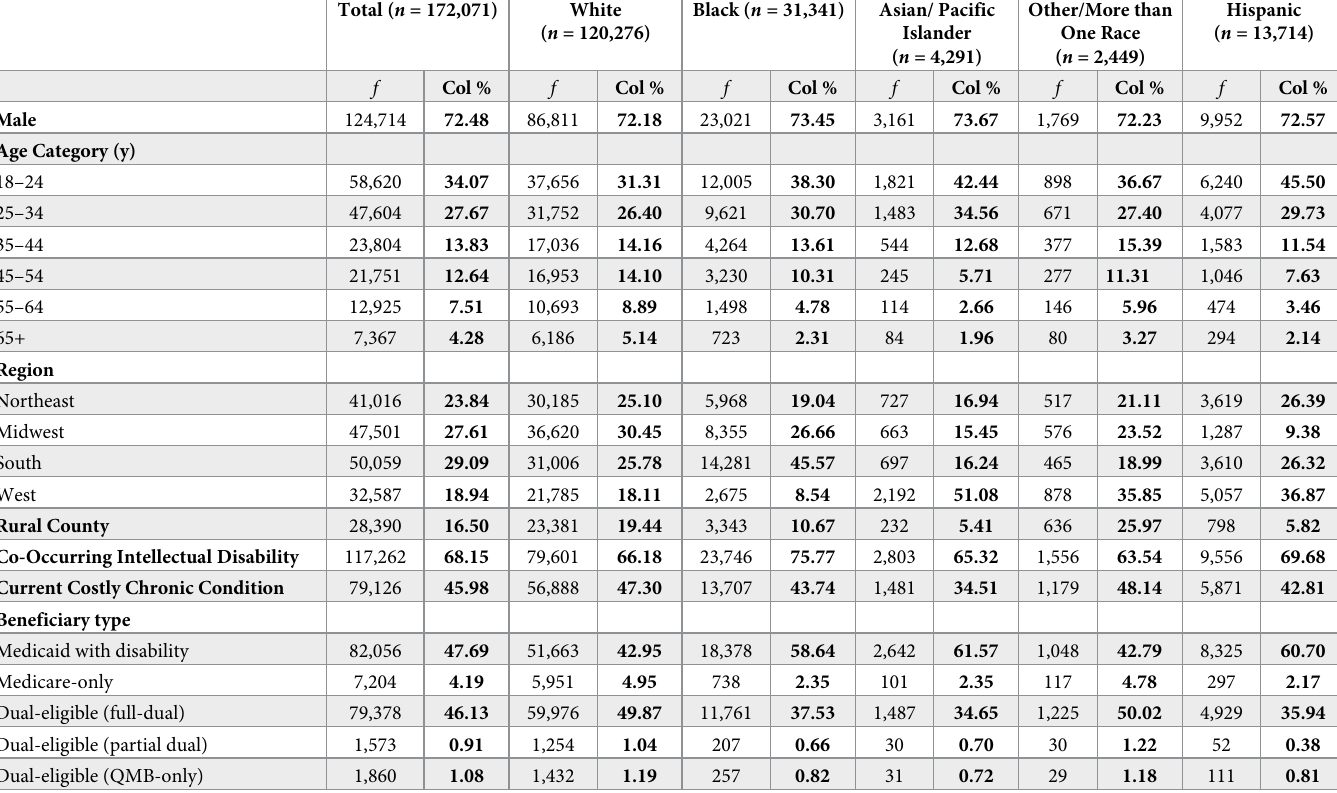
Table 1. Demographic and beneficiary type by race-ethnicity of adults with autism spectrum